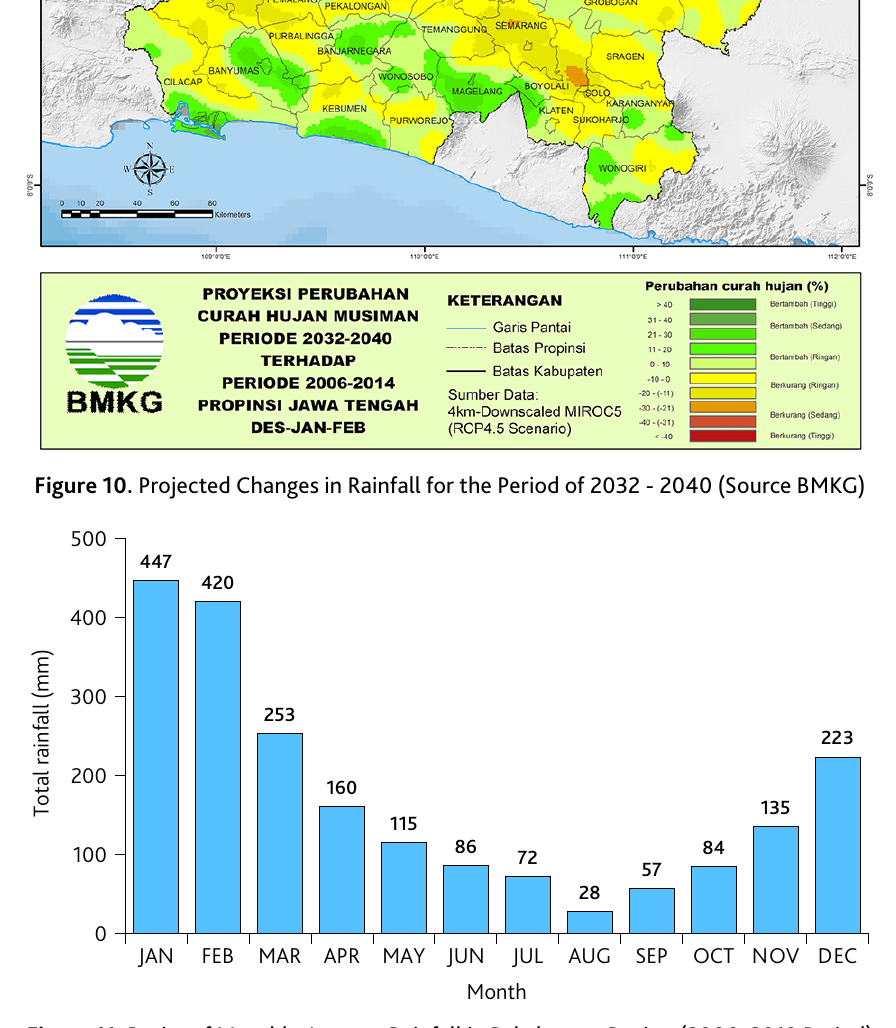
Figure 11. Rezim of Monthly Average Rainfall in Pekalongan Region (2000-2019